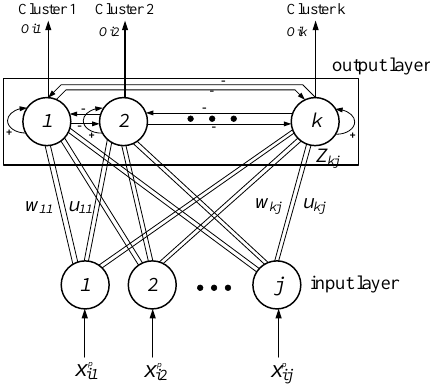
Figure 3. Extension neural network (ENN) architecture. 170